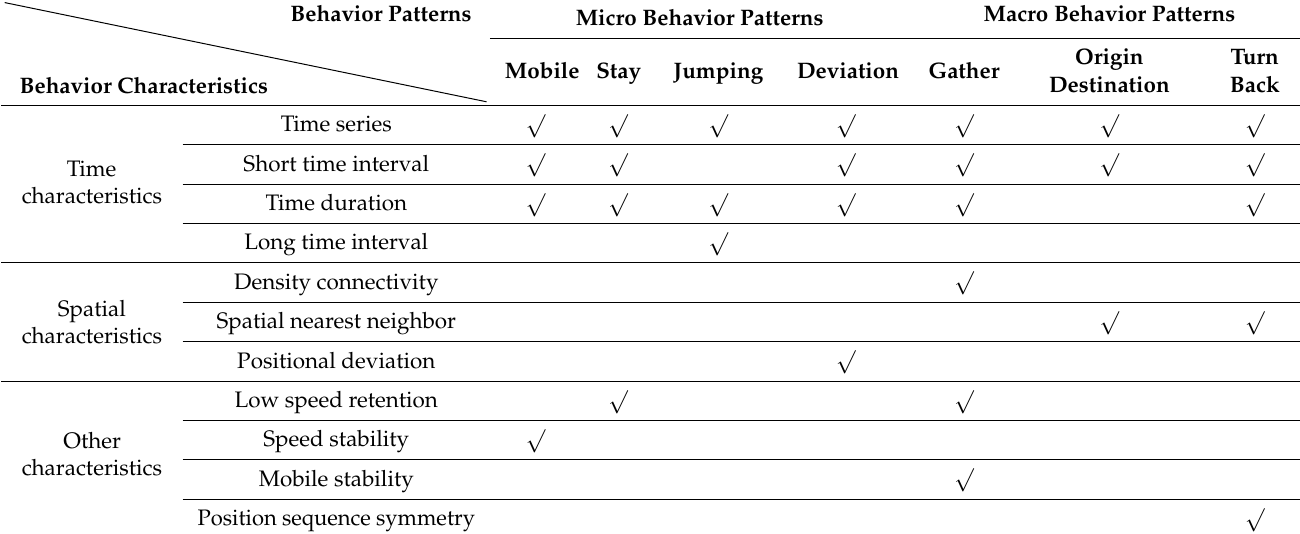
Table A1. Ship trajectory characteristics and behavioral patterns.